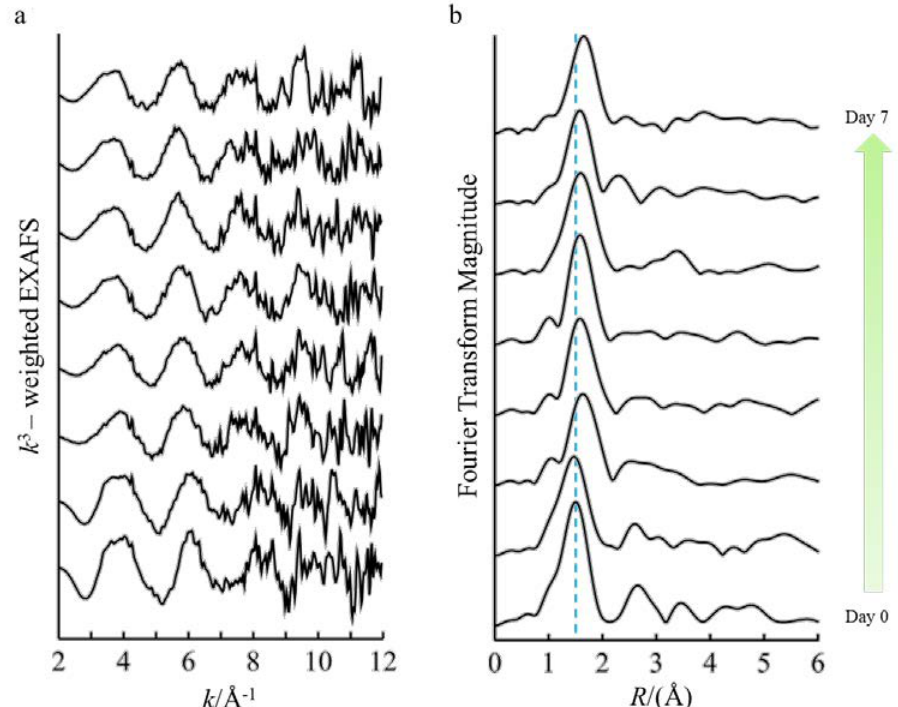
Figure 3. Fe K-edge EXAFS spectra ( a ) and corresponding Fourier transforms ( b ). Samples were collected daily (from day 0 to day 7) from culture filtrates of P. involutus growing on BSA-containing medium. The blue dashed line serves to identify changes in the peak positions.